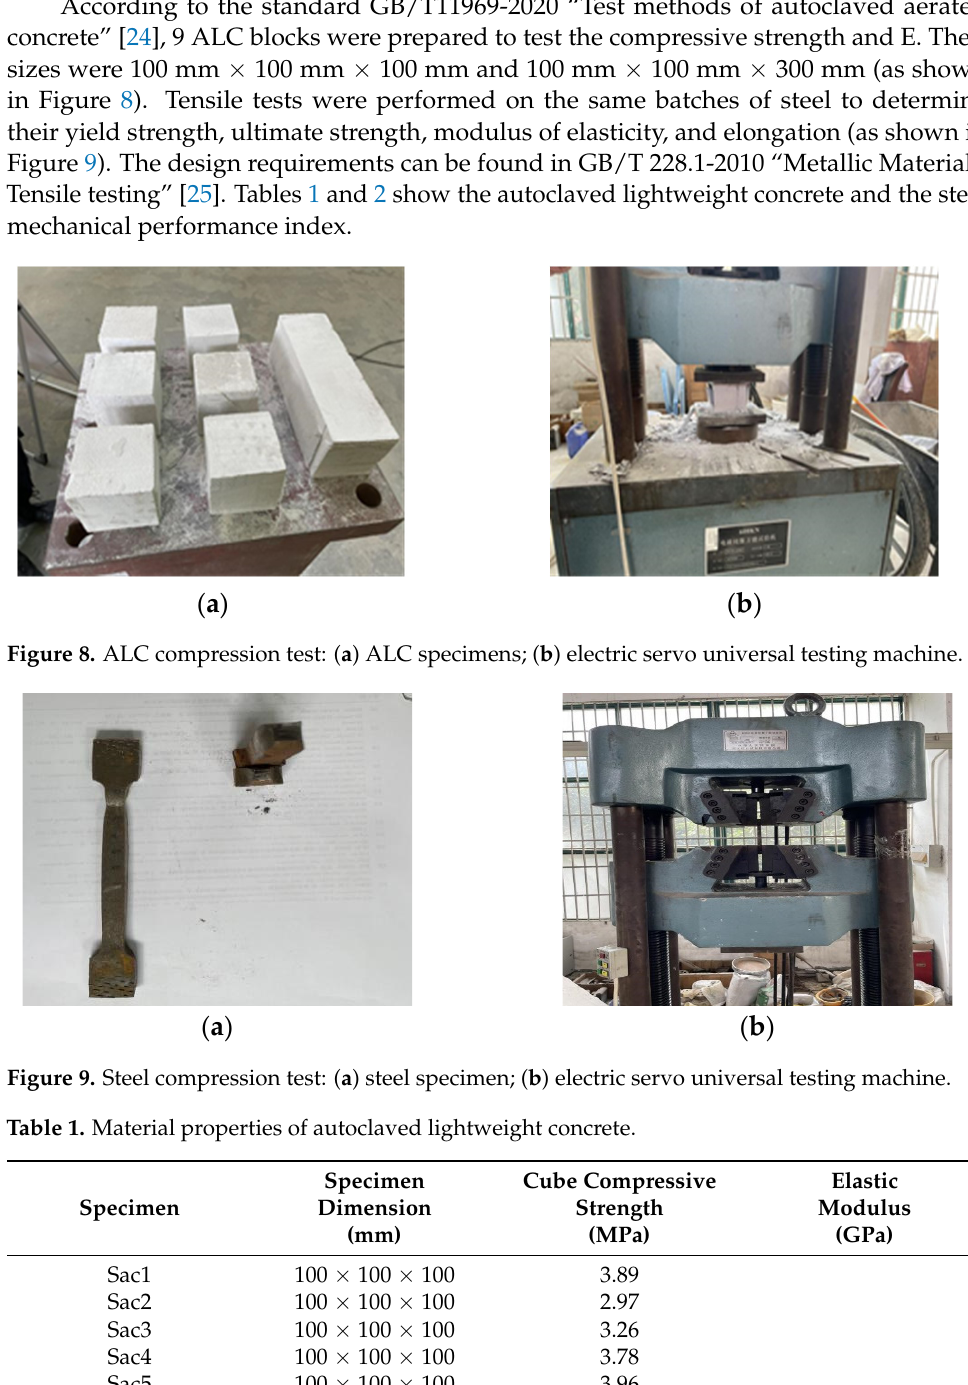
Figure 7. Connector installation schematic: ( a ) assembling steel frame; ( b ) positioning of the con- nector; ( c ) welding bracket plate; ( d ) welding connector; ( e ) panel lifting; ( f ) applying caulking mor- tar.